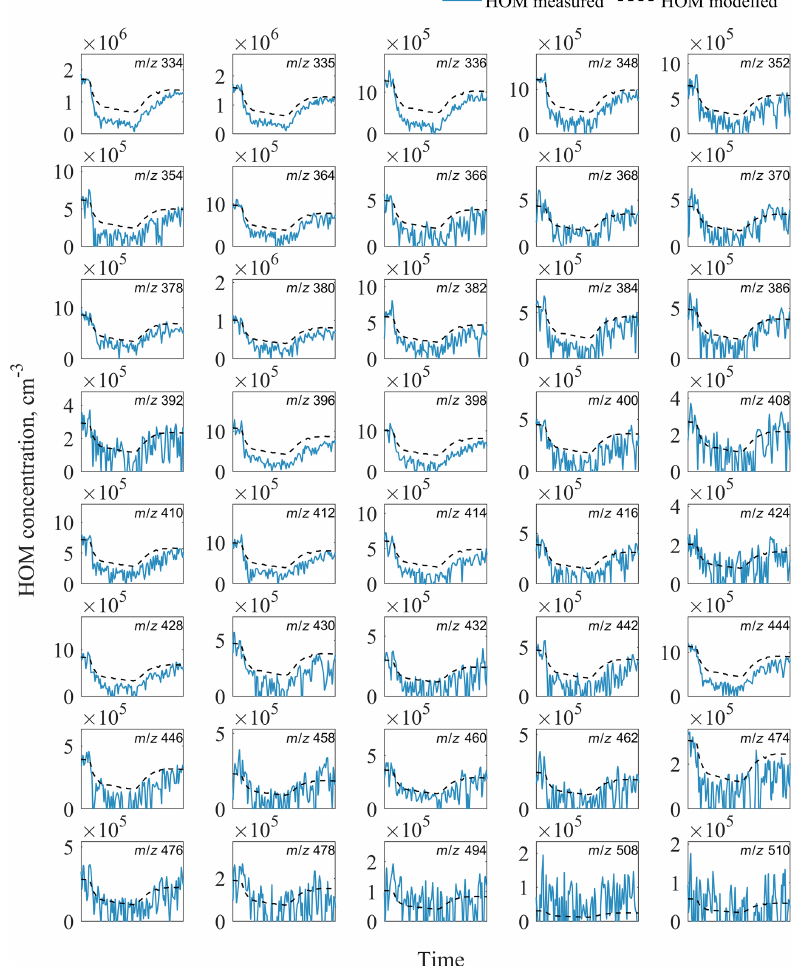
Figure A2. Evolution of measured and modelled HOM dimers during the seed addition experiment. The list of HOM compositions for each peak at corresponding m/z is presented in Table S4 in the